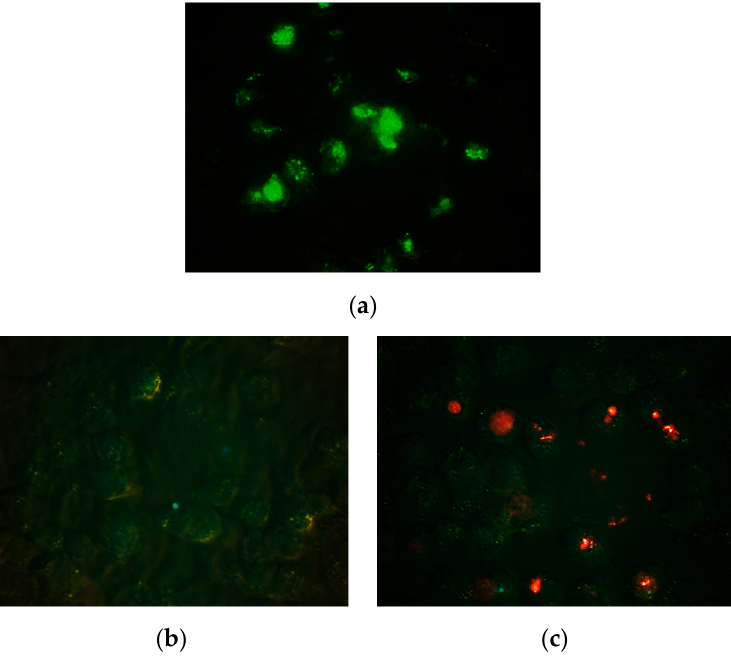
Figure 2. Fluorescence images of HEP-G2 cells exposed to CdSTe QDs synthesized at ( a ) 120 °C, ( b ) 150 °C, and ( c ) 180 °C (40×). Cells were exposed to 10 mg/L of each QD for 4 h at 37 °C and 5% CO 2 and fixed with p-formaldehyde. Excitation wavelength was 365 nm (50 nm) and emission was above 450 nm.